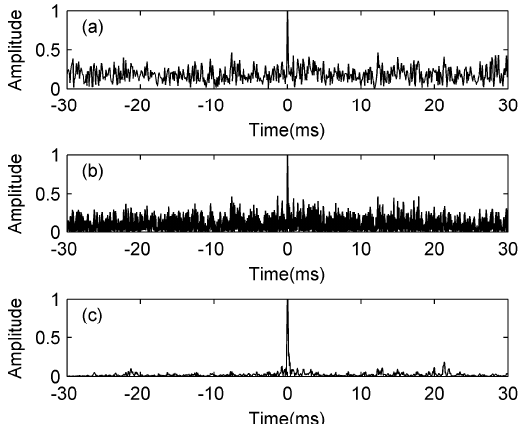
Figure 5. Normalized outputs of the concise fractional Fourier transform (CFRFT), the MF and the FDAMF when input signal to noise ratio (SNR) = − 10 dB. ( a ) CFRFT (SNR = 20.2 dB); ( b ) MF (SNR = 21.4 dB). ( c ) FDAMF (SNR = 35.3 dB).